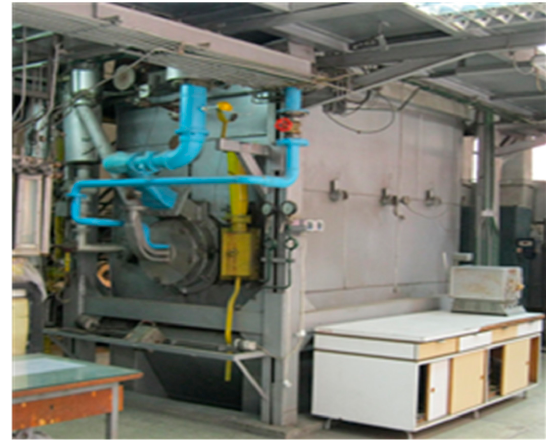
Figure 7. Kinematic viscosity comparison.